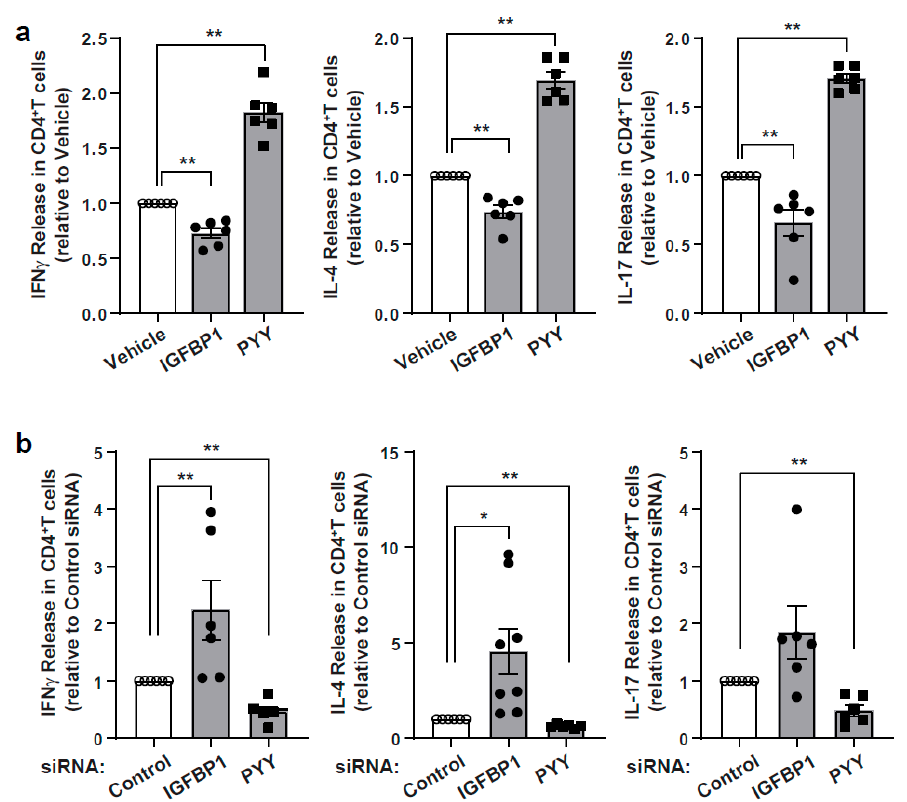
Figure 4. Characterization of immunomodulatory effects of IGFBP1 and PYY. ( a ) Cytokine release